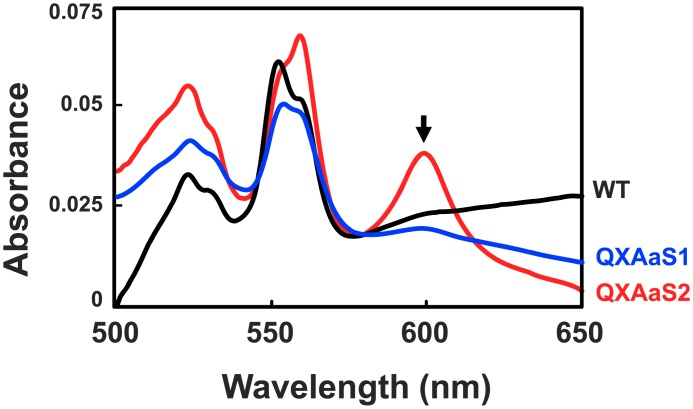
Reduced minus oxidized difference absorbance spectra of membranes from WT, QXAaS1, and QXAaS2.Strains were cultivated aerobically in glutamate medium. Solubilized membrane fractions were oxidized and reduced by ammonium persulfate and sodium dithionite, respectively. The absorption peak at 598 nm specific to heme a is indicated by an arrow. Black, blue, and red curves indicate WT, QXAaS1, QXAaS2, respectively.